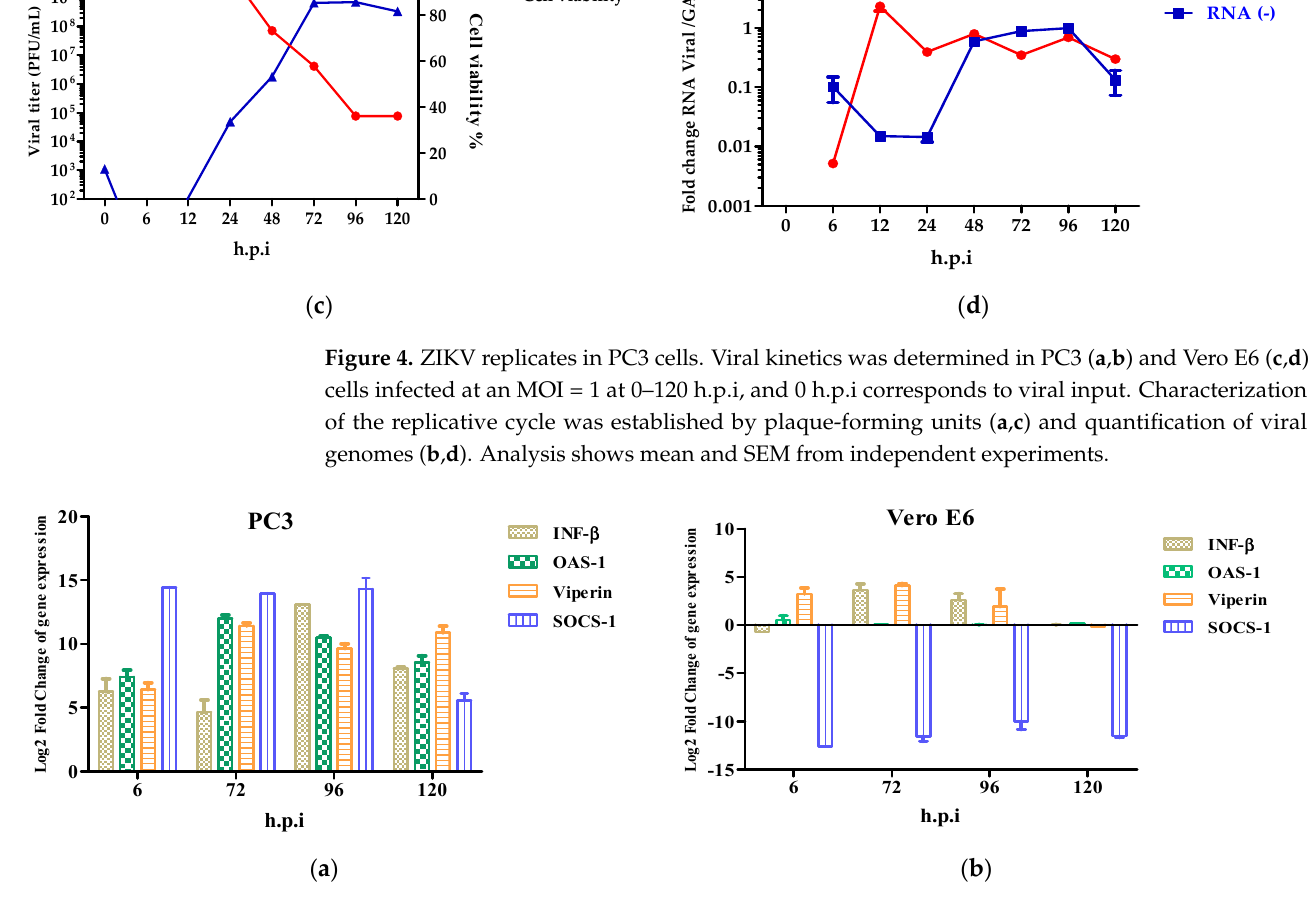
Figure 5. Innate immune response to Zika virus in PC3 ( a ) and Vero E6 ( b ) cells were evaluated at 6, 72, 96, and 120 h.p.i by RT-qPCR. mRNA expression of β and antiviral proteins (OAS1, Viperin, and SOCS-1) in ZIKV-infected PC3 ( a ) and Vero E6 ( b ) were determined. Data are presented as the mean ± SEM from three independent experiments.